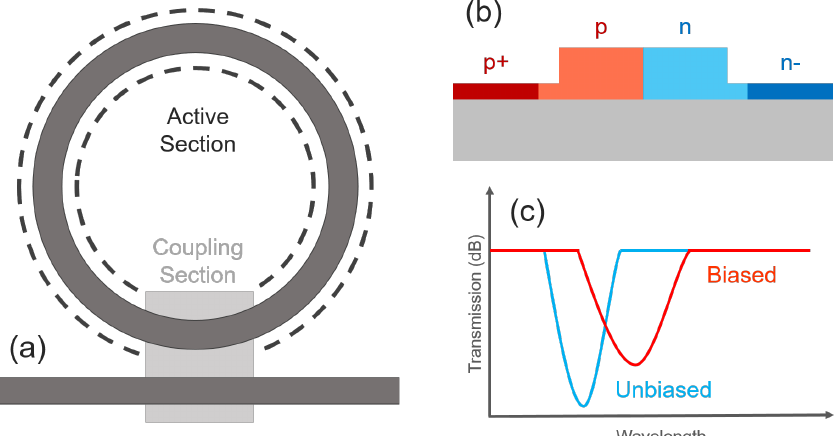
Figure 1. Ring modulator schematic with ( a ) Top down view showing the ring and the coupling waveguide ( b ) the diode embedded in the cross section ( c ) The effect biasing has on the transmission of the